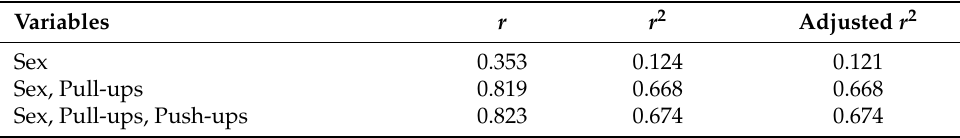
Table 3. Stepwise linear regression analysis for the leg tuck with sex and the other fitness tests (Illinois agility test, metronome push-ups, pull-ups, 4.54 kg backwards overhead medicine ball throw, estimated maximal aerobic capacity from the 20 m multistage fitness test, 10RM deadlift, and the farmer’s carry) for firefighter trainees ( N = 305). Significance was p <